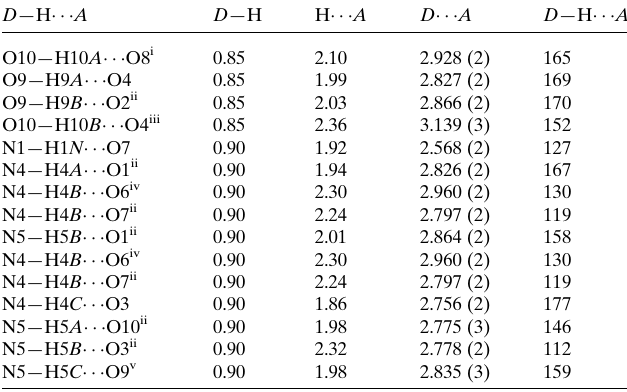
Figure 2 A view along the a axis of the packing and hydrogen bonding of the title compound.